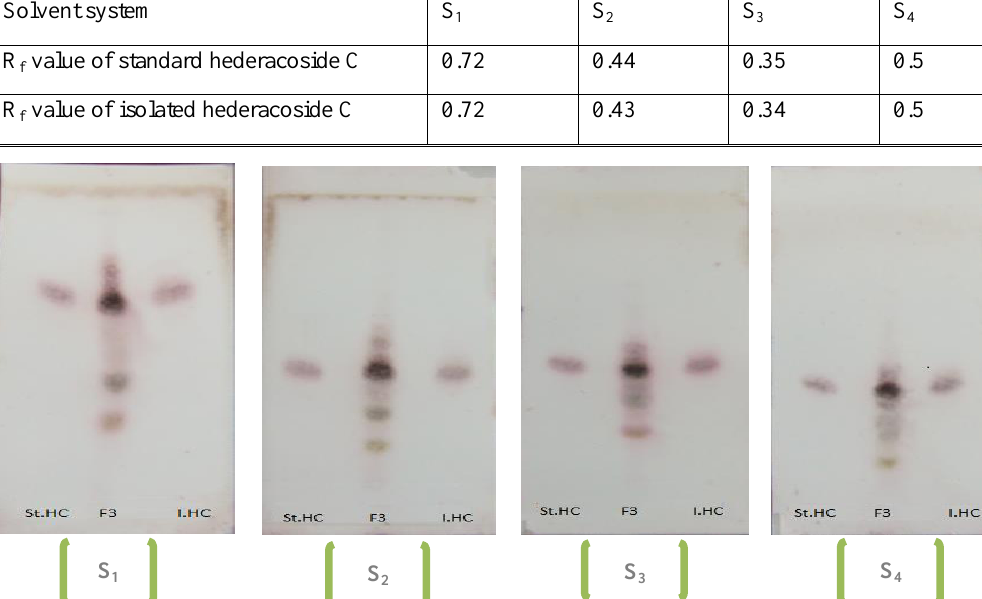
Table (5): The R values of isolated hederacoside with its reference standard in different f developing solvent systems using TLC technique: